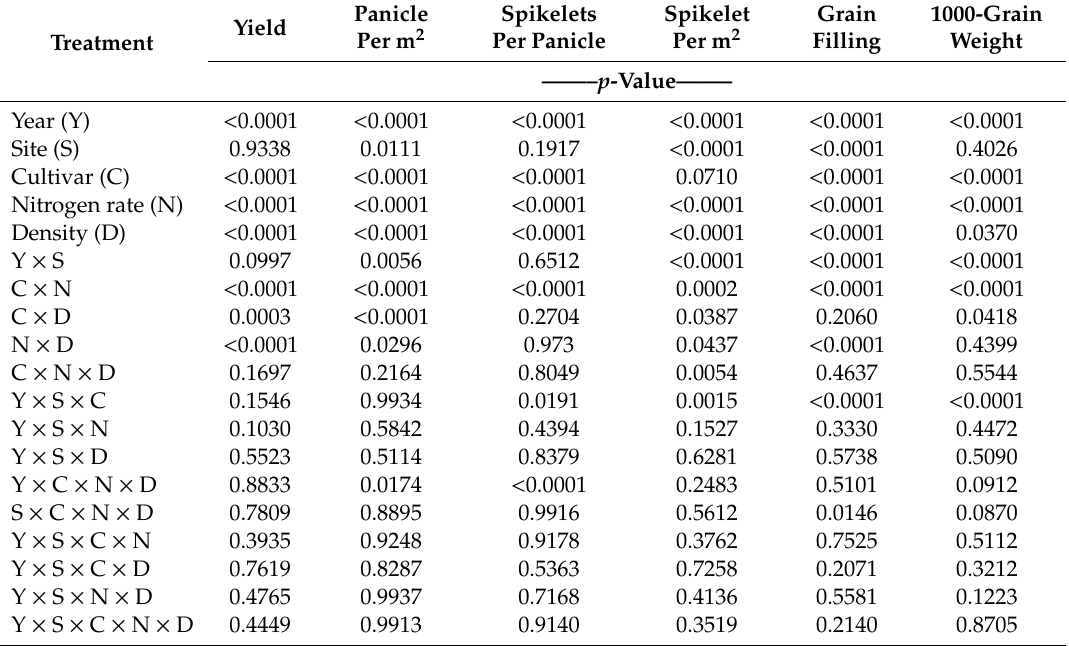
Table 2. Analysis of variance (ANOVA) for grain yield and yield related